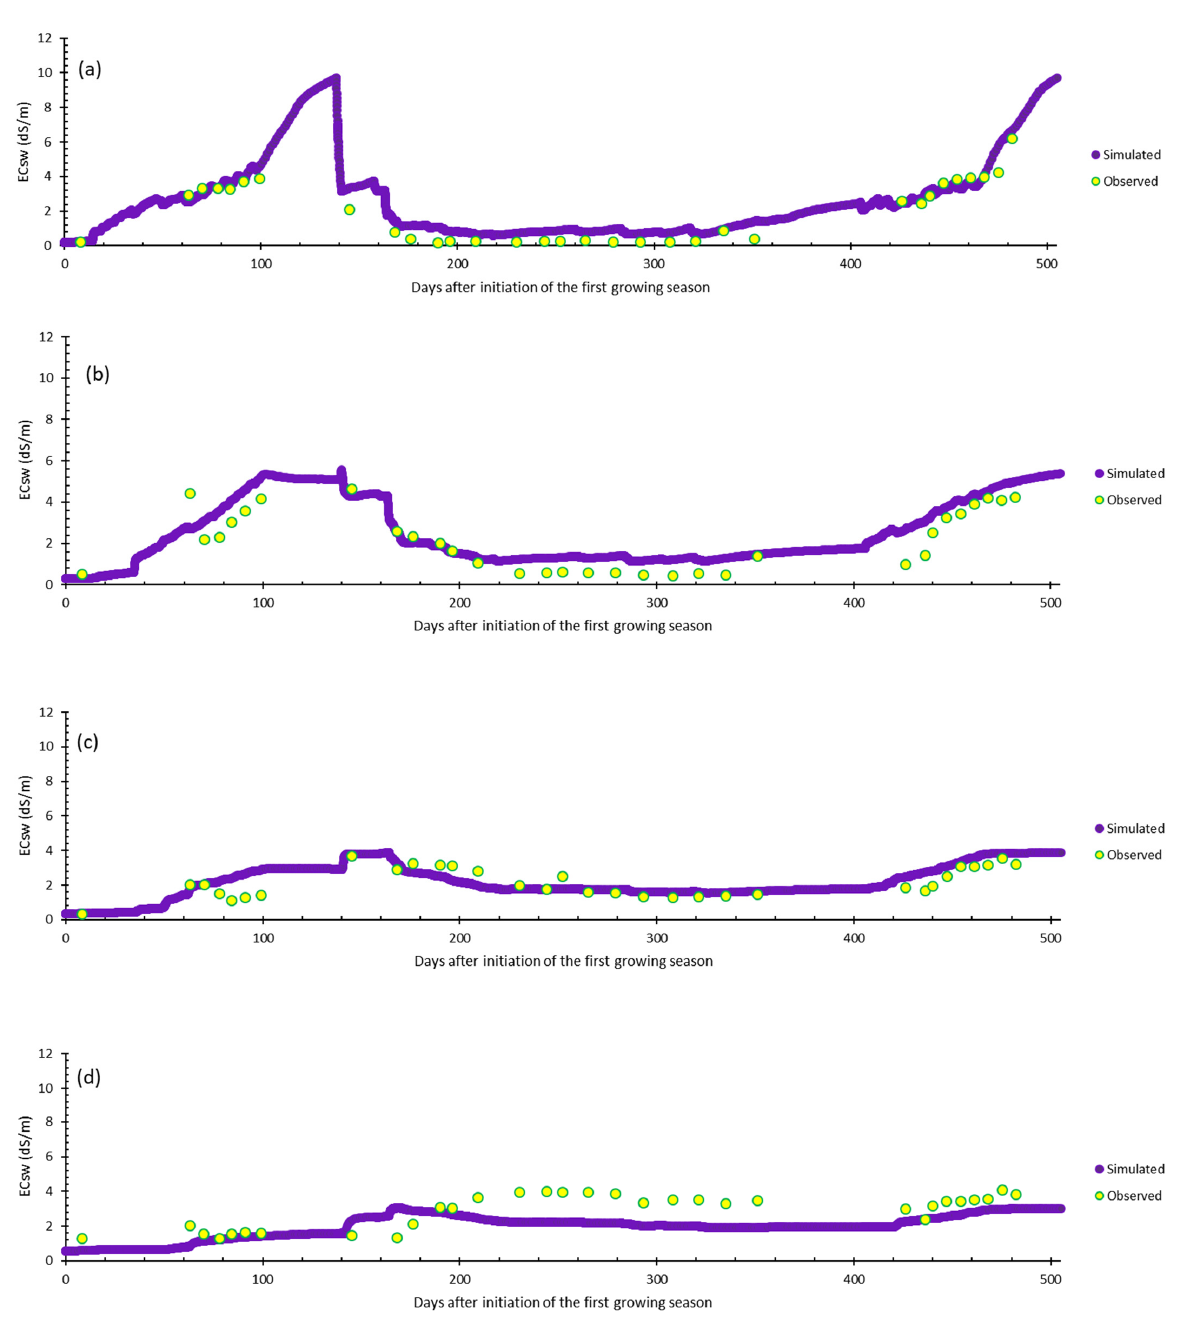
Figure 7. Time series of the simulated ECsw during the growing season and out of the growing season with observational measurements for two years of study at ( a ) 10, ( b ) 30, ( c ) 50, and ( d ) 70 cm soil depth.